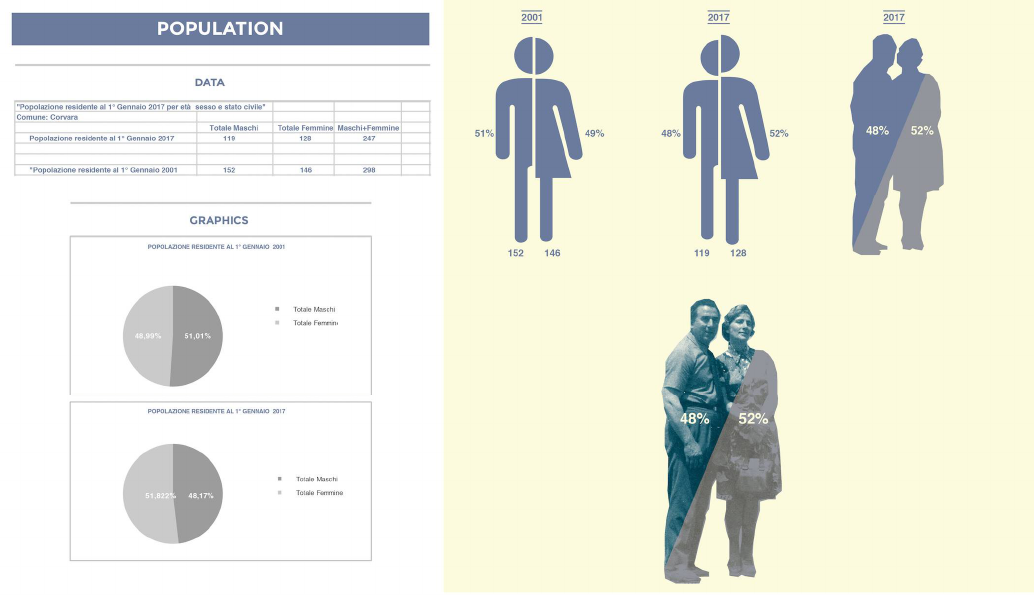
Figure 3. Representing the comparison between two indicators: the man-woman relationship within the resident population between 2001 and